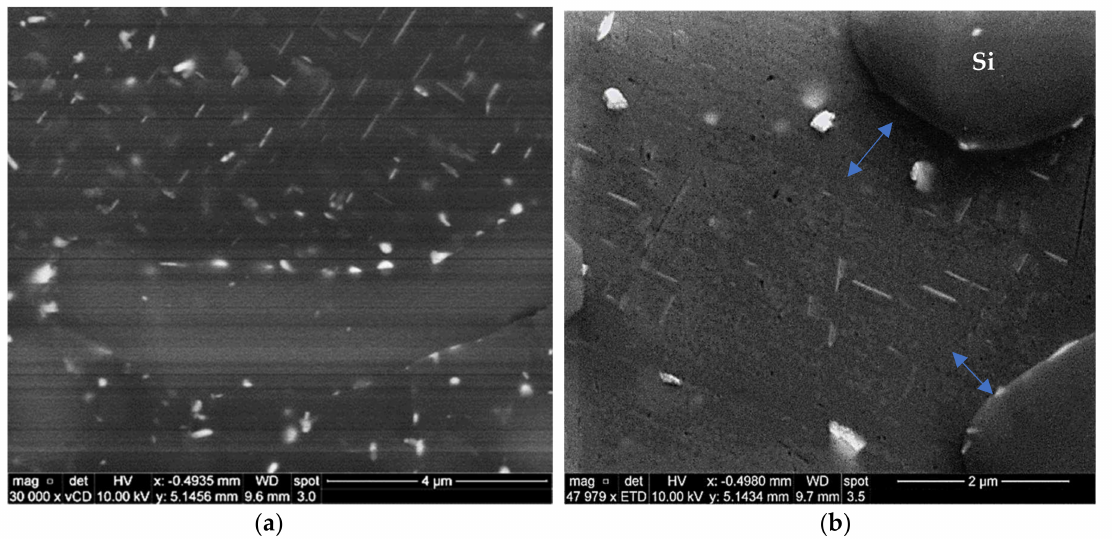
Figure 11. Backscattered electron images from T6-treated M2S alloy after stabilization at 250 ◦ C for 200 h: ( a ) low magnification, ( b ) high magnification of ( a ) showing PFZs (blue arrows).